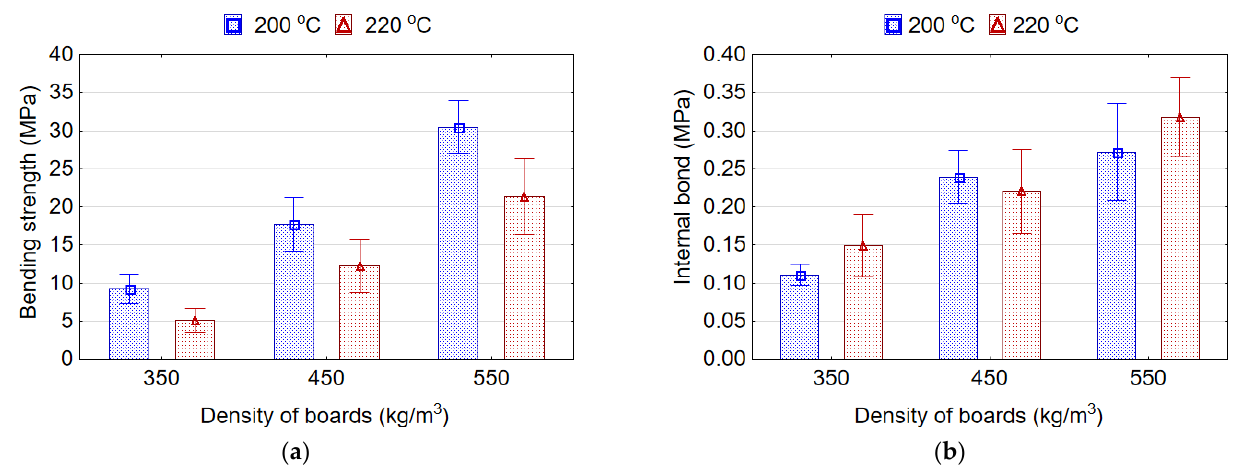
Figure 8. The bending strength ( a ) and internal bond strength ( b ) of the lightweight particleboards.